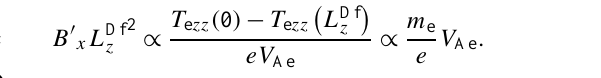
Figure 5. Time evolution of averaged slopes of B x variations in the z direction over | z | < L Df z divided by (m e /m i ) − 1 / 2 β Runs 2 (red), 5 (green) and 8 (blue) (a) , and L Df z and L NG z for Run 2 (b) . The shaded interval indicates the quasi-steady phase for Run